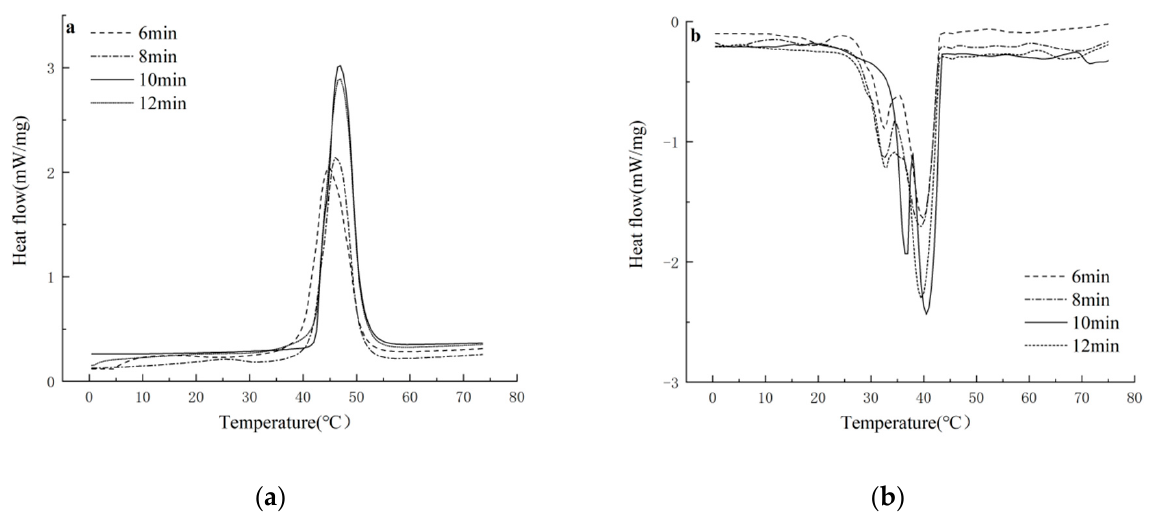
Figure 6. DSC curves of MPCMs with different ultrasonic oscillation time in the SDS ratio of 0.22%, ultrasonic oscillation time of 10 min, pH of 4.5, core–shell ratio of 1:1. ( a ) Melting and ( b ) crystallization processes at a temperature rate of 10 K/min in a 60 L/min flow of N 2 . Table 6. Experimental results for changing ultrasonic oscillation time.